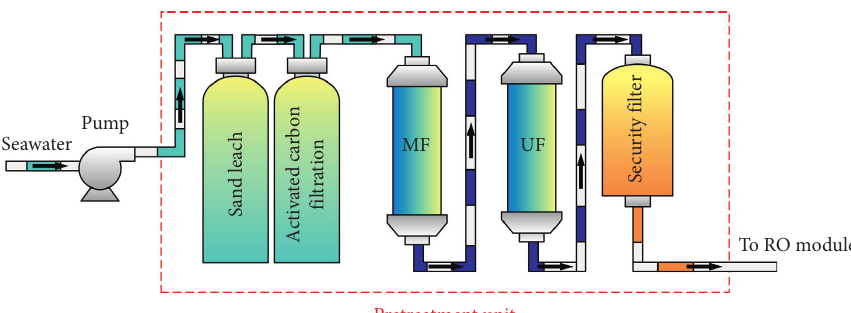
Figure 4: Pretreatment combination of RO desalination.